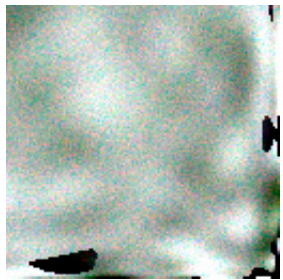
Figure 15. Synthetic image (SNR = 30 dB).